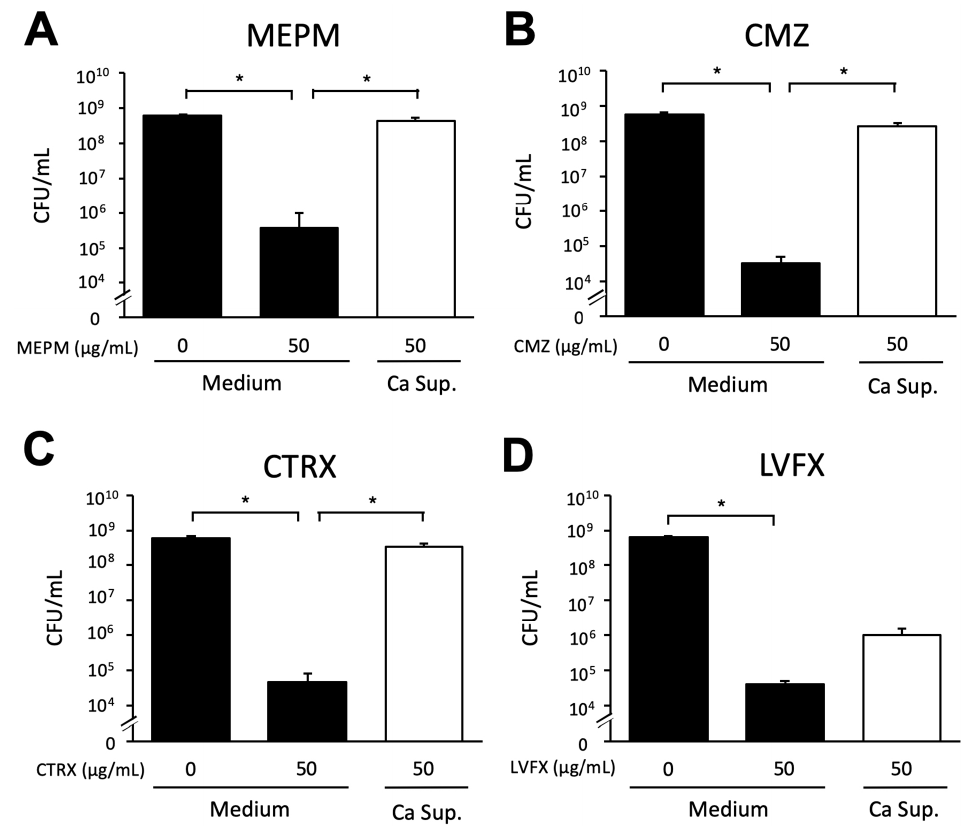
Figure 4. Effect of C . albicans culture supernatant on E . coli biofilm formation in the presence of antimicrobial agents. E . coli RB-3 survival in the presence of Candida culture supernatant (Ca Sup.) and 0 or 50 µ g/mL MEPM, CMZ, CTRX, or LVFX ( A – D ). Measurements were performed three times, and the data are presented as the mean ± standard deviation. n = 3/group. Statistically signif ‐ icant differences between groups were evaluated using Tukey’s test with one ‐ way ANOVA; * p < 0.05.